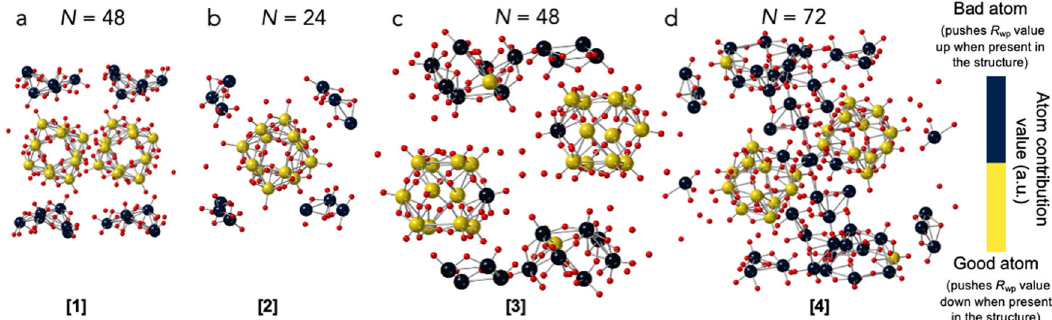
Fig. 9 Summary of the ML-MotEx analysis of experimental PDFs from Keggin clusters in solution. Results from the ML-MotEx method on a PDF from a solution of ammonium metatungstate hydrate, using four different starting models: a [Hpy] 4 H 2 [H 2 W 12 O 40 ] (py = pyridine) 32 , b (CH 3 ) 4 N) 4 SiW 12 O 4033 , c (((CH 3 ) 2 NH 2 ) 6 (Cu(HCON(CH 3 ) 2 ) 4 )(GeW 12 O 40 ) 2 )(HCON(CH 3 ) 2 ) 234 , d ((CH 3 ) 2 NH 2 ) 3 (PW 12 O 40 ) 35 . Atoms kept by ML-MotEx are shown in yellow while removed atoms are shown in black. The kept atoms were chosen as the 24 atoms (model A), 12 atoms (model B), 24 atoms (model C), and 24 atoms (model D) with the lowest atom contribution values. In Supplementary Fig. 6 a similar representation is shown, but where the atom contribution values are directly shown using a continuous colour